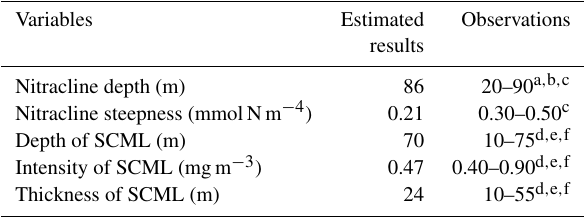
Table 2. Estimated results and observed values at SEATS station.